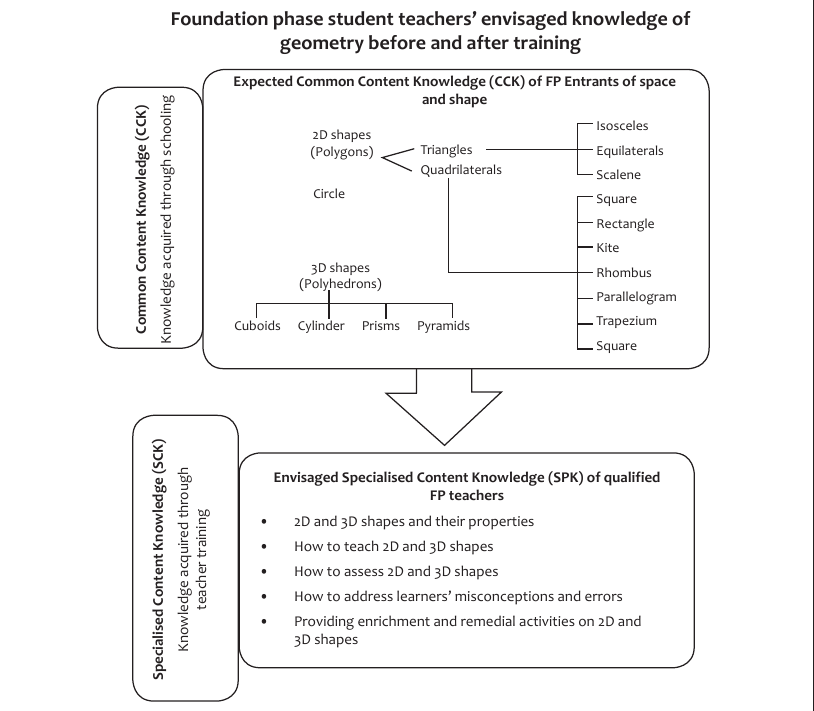
Figure 2: Foundation phase student teachers’ envisaged knowledge of geometry before and after training (Developed from the NCS (RSA DBE